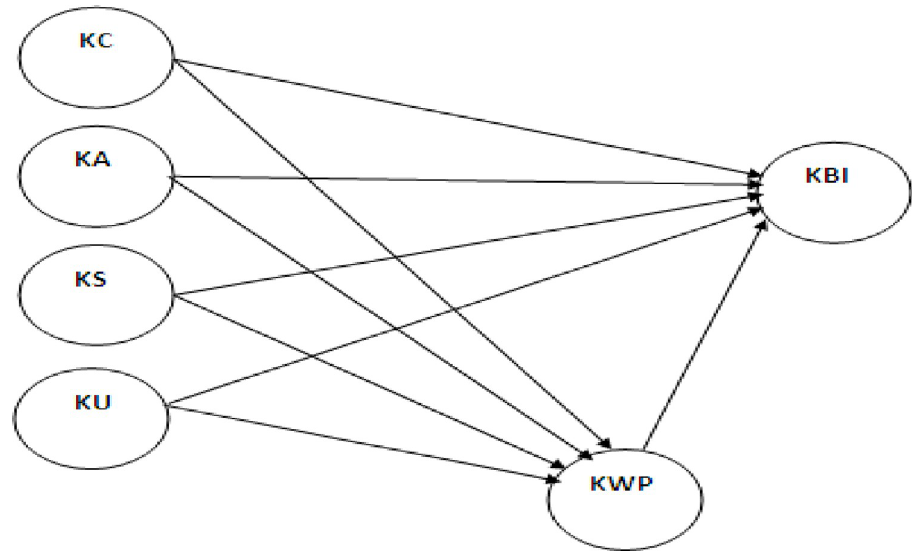
Fig 1. Research framework.